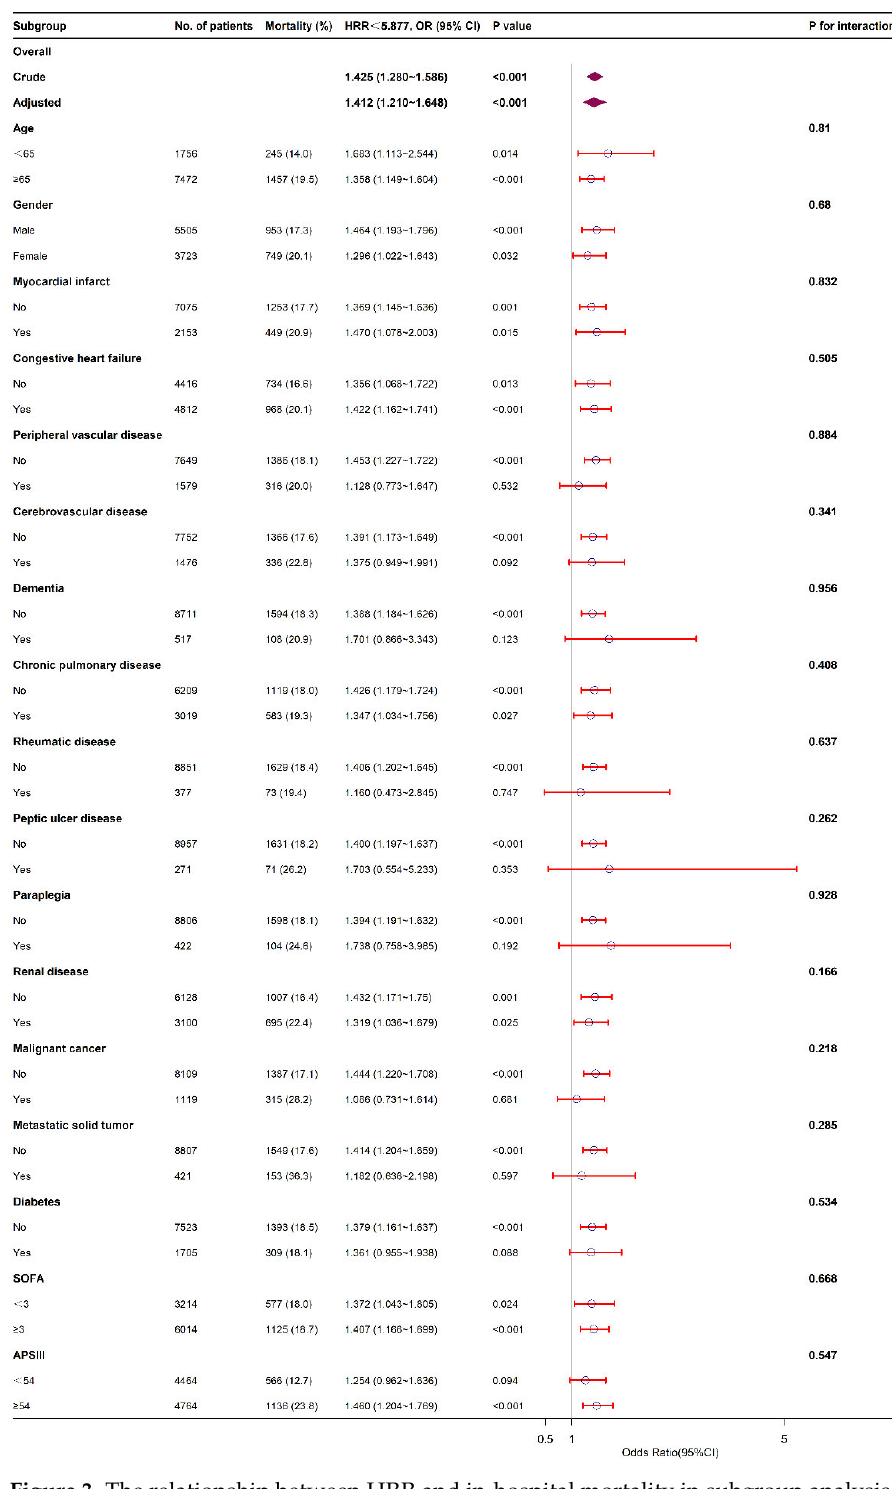
Figure 3. The relationship between HRR and in-hospital mortality in subgroup analysis. and represent the HR value. Red bands present the 95% confidence interval. 3.6. Prognostic Value of HRR after PSM